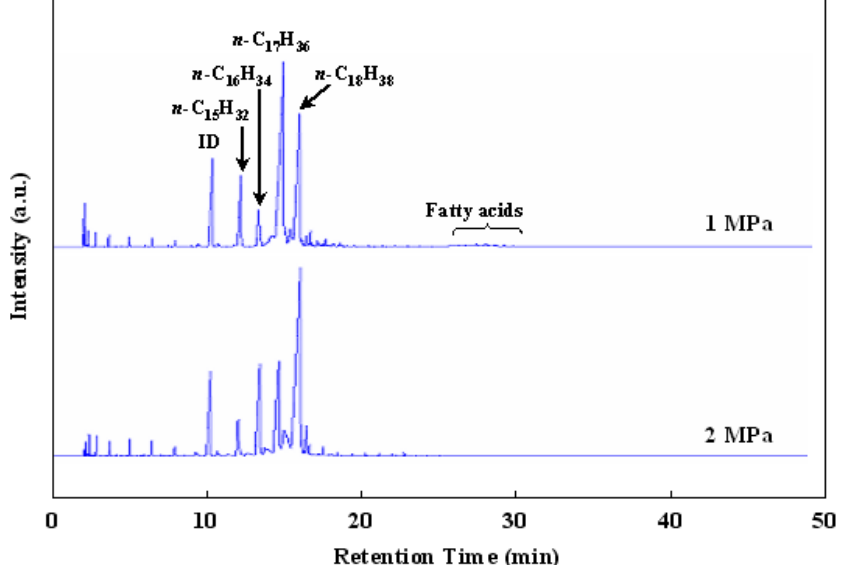
Figure 6. FID-GC charts of liquid products in the hydrotreatment of waste cooking oil -Mont under various H over Ru/Al 13